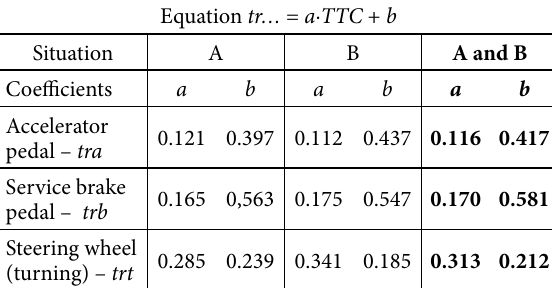
Fig. 15. Average reaction times for ‘Scenario 5’, without distinguishing between situations A and Table 5. Summary of the linear regression equation coefficients of drivers’ reaction